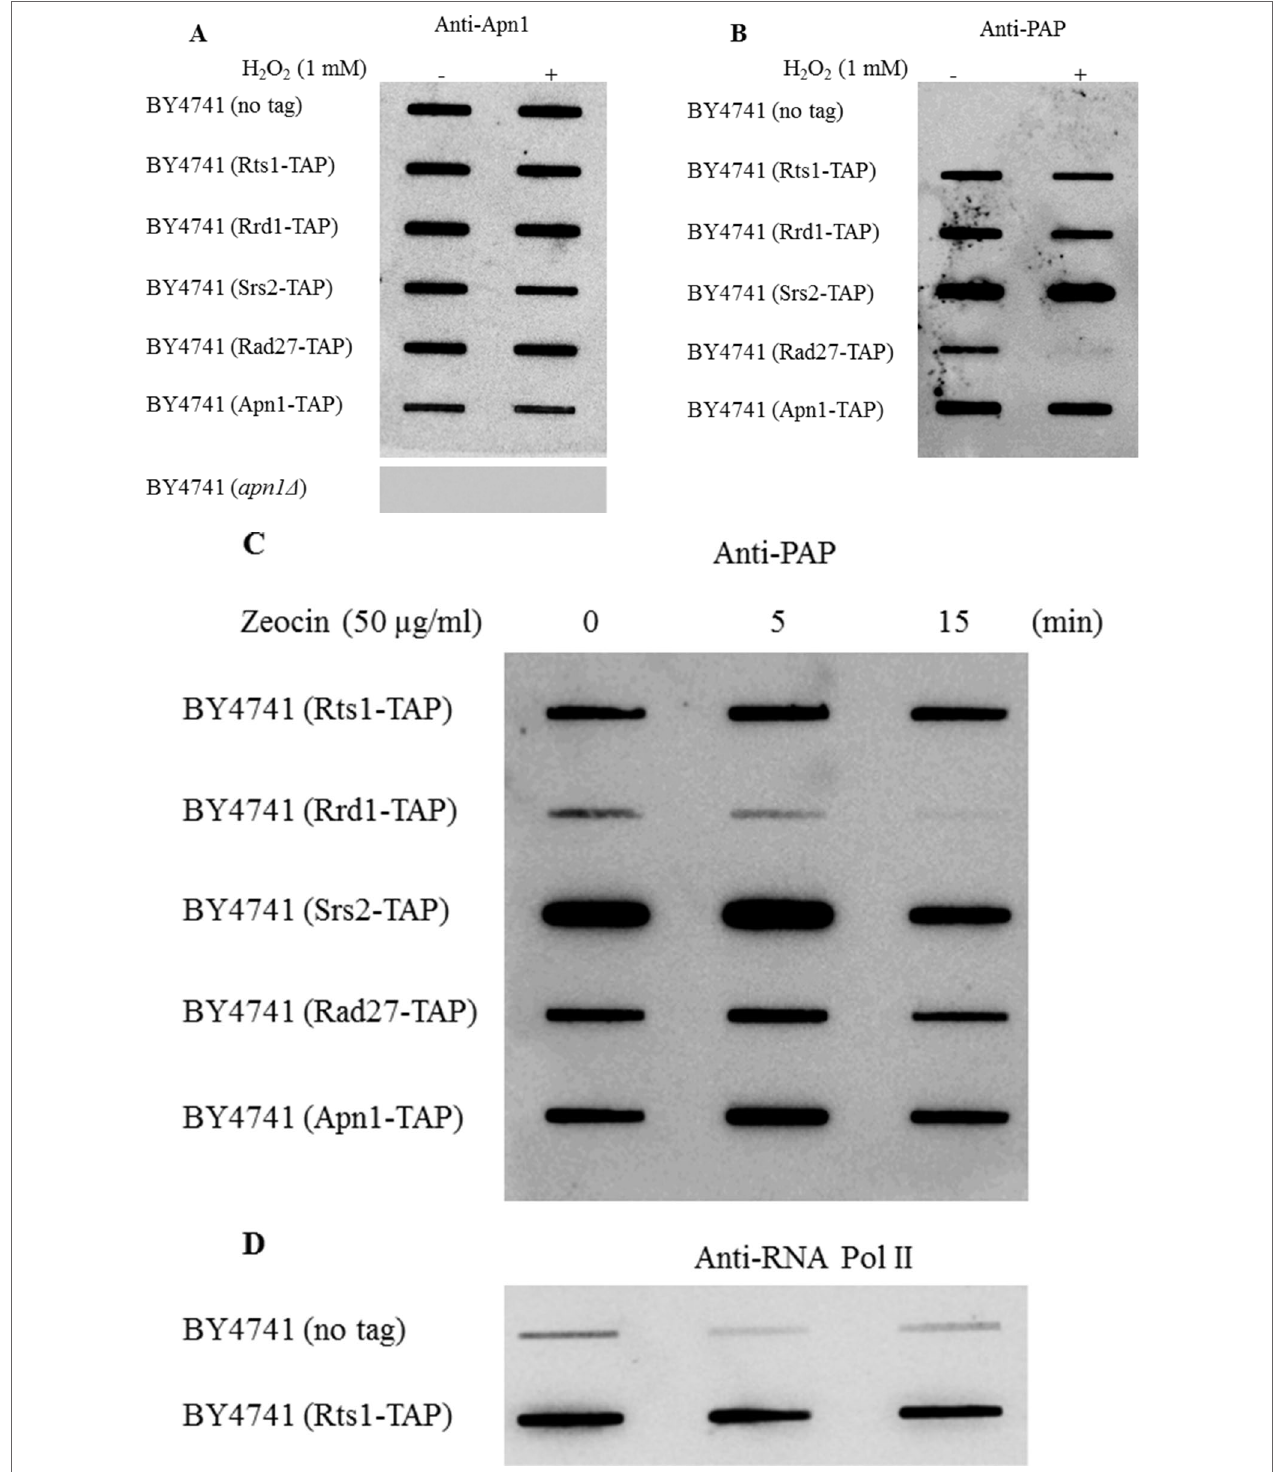
fIGURe 4 | Rts1-TAP is bound to the chromatin similar to the Tandem Affinity Purification (TAP) tagged DNA binding proteins Srs2, Rad27, and Apn1. (A , B) The indicated strains were untreated and treated with H 2 O 2 (1 mM for 30 min) and 700 ng of the protein bound DNA from each sample (see RADAR Assay ) was loaded onto a slot blot and assess for the binding of the indicated nuclear proteins using antibodies against Apn1 and the TAP tag (anti-PAP), respectively. For the anti- Apn1 control, the apn1Δ mutant was used and for the anti-PAP control the parent strain BY4741 was used that lacks an endogenous TAP tag. (C , D) Cells were treated with the phleomycin analogue zeocin and processed by the RADAR assay. The blots were probed with anti-PAP (C) and anti-RNA polymerase II (D) . The data are representative of three independent experiments.